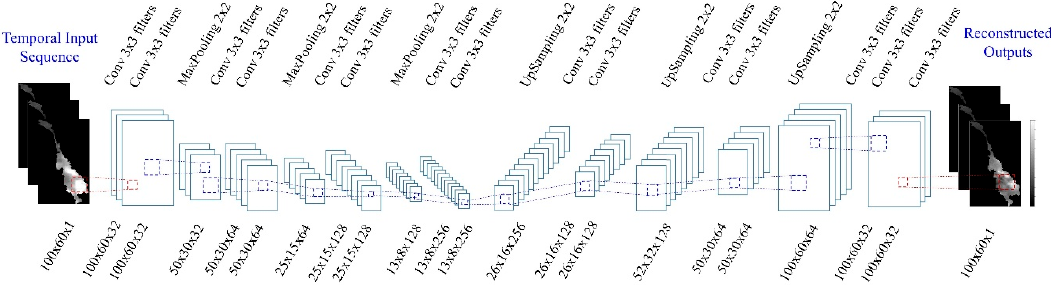
Figure 6. Convolutional autoencoder (ConvAE) model the structure for the precipitation bias correction problem. Here, “100 × 60 × 1” refers to “height × width × depth”. With the 2D data, the default value of depth is 1.